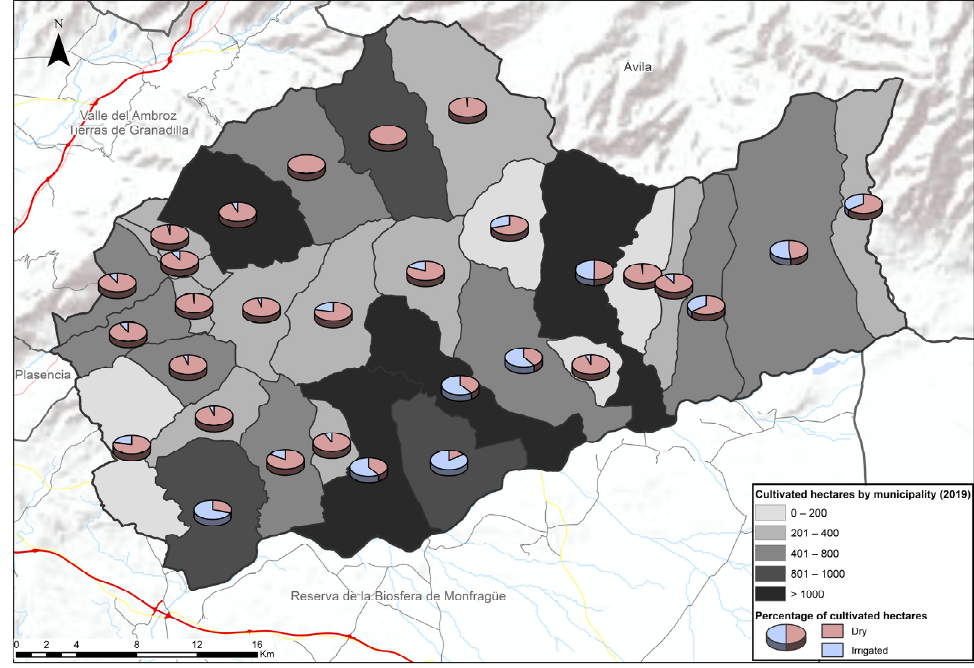
Figure 5. Map of the cultivated hectares and their typology by municipality.